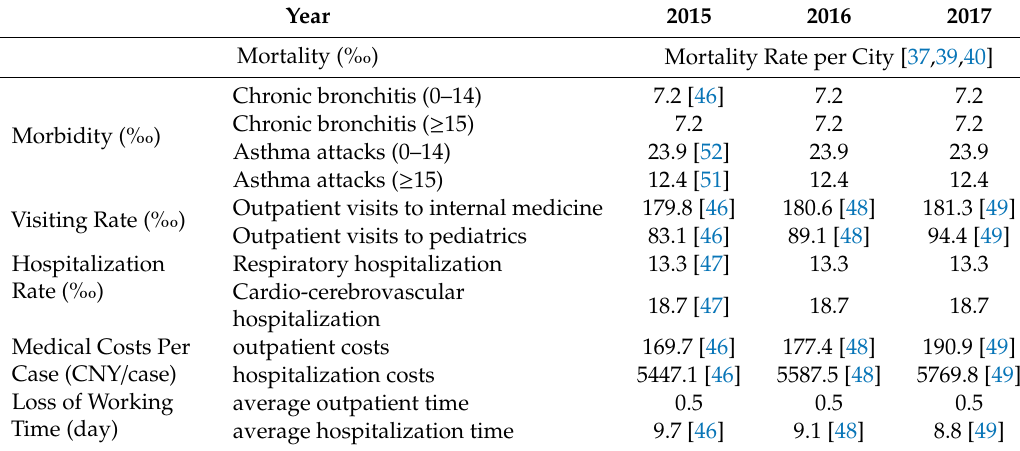
Table 2. The health information in